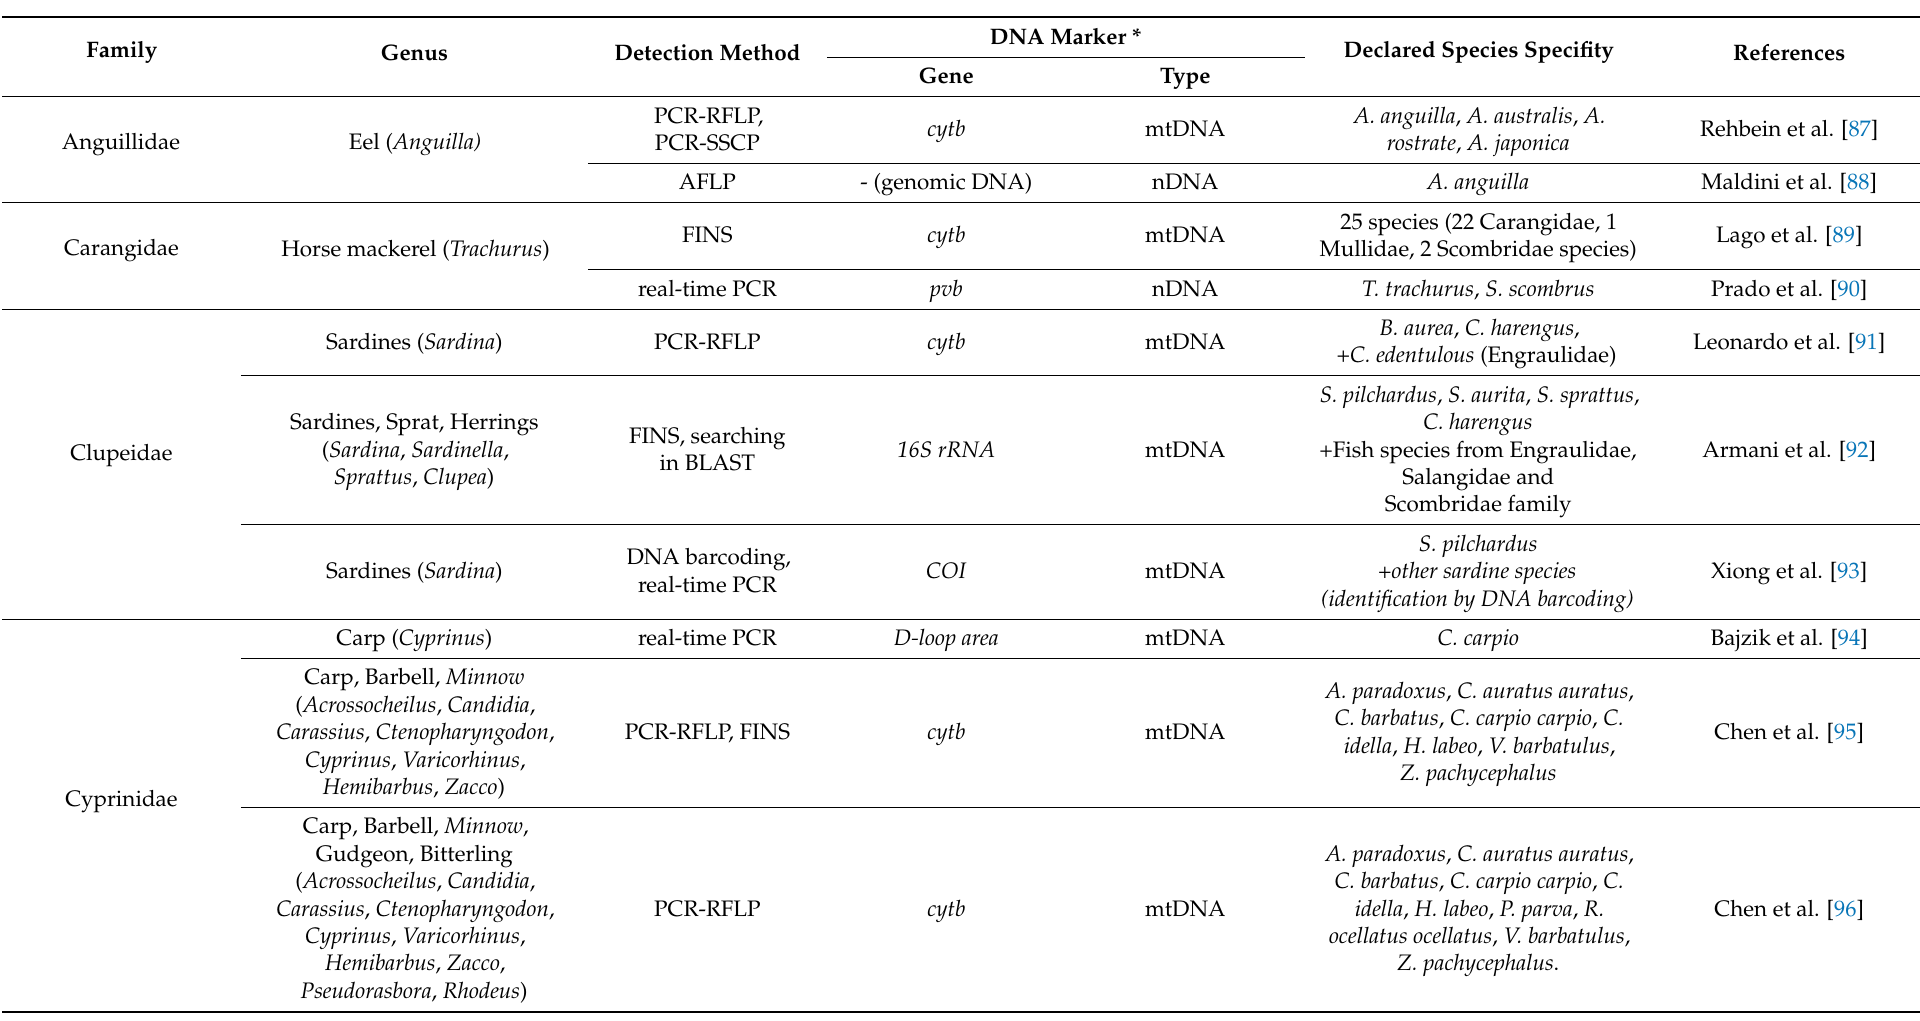
Table 1. Overview of mitochondrial and nuclear DNA markers used for fish species